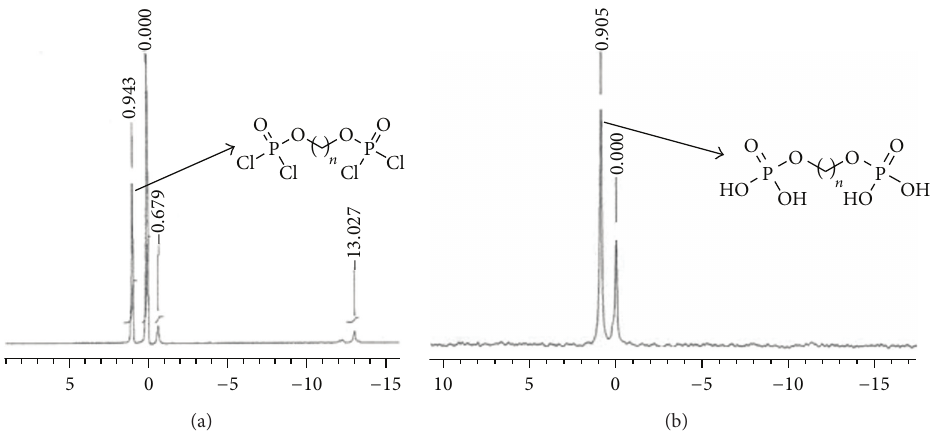
Figure 3: 31 P NMR spectra of 1,12-Bis[(dihydroxyphosphinyl)oxy]dodecane obtained with method 3 . (a) Crude mixture obtained